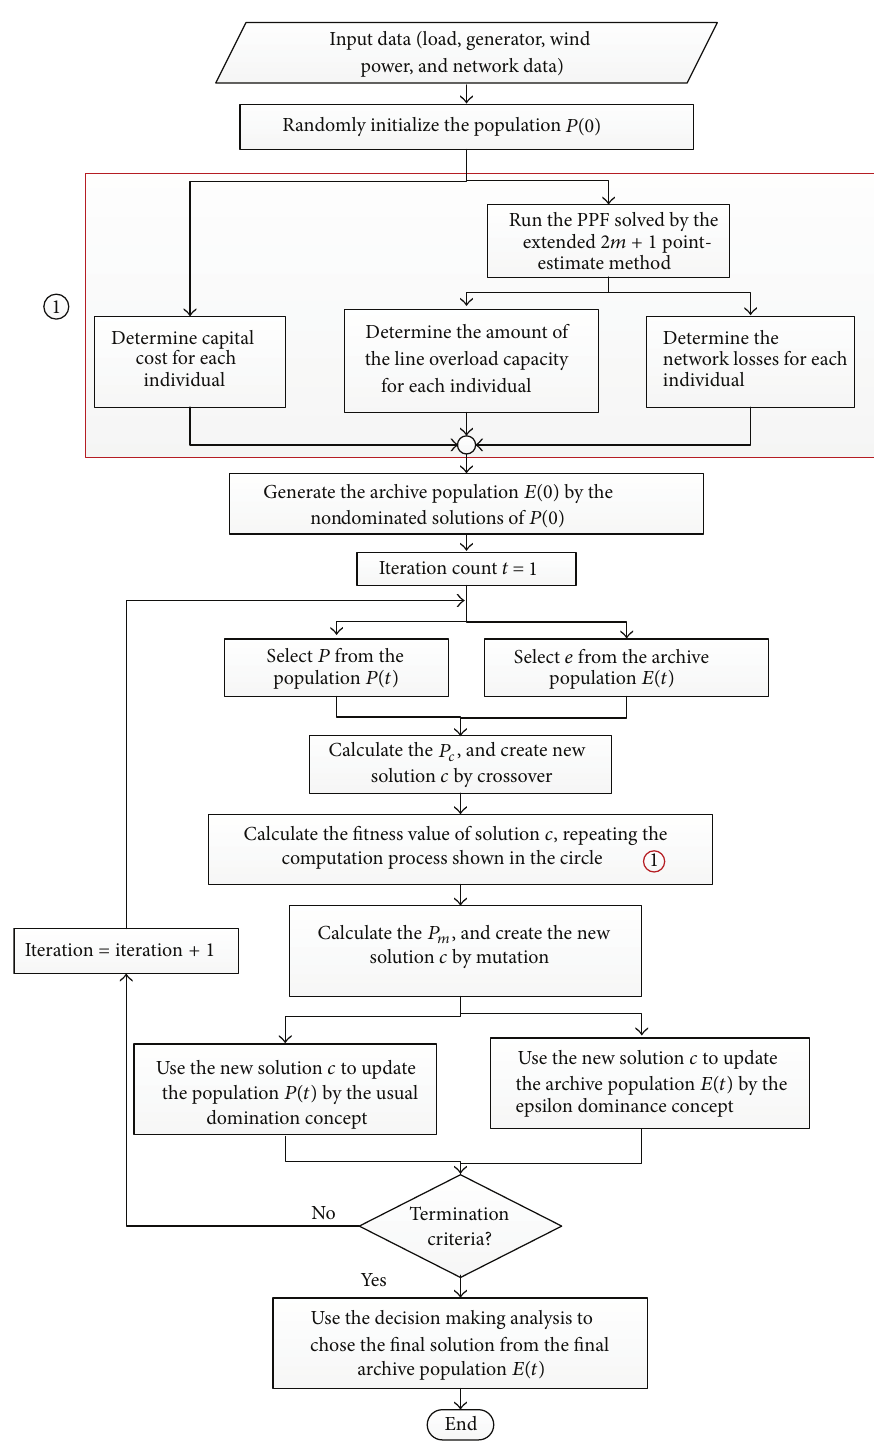
Figure 4: Flowchart of the proposed